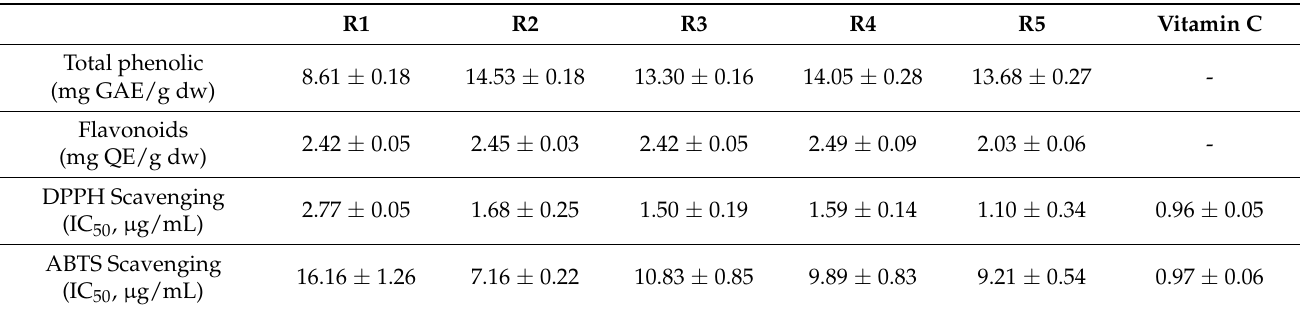
Table 1. Comparison of the total phenolics and flavonoids content and antiradical activity of R1–R5 extracts from various parts of R. platyacantha; each value represents mean ± SD ( n = 3). R1 R2 R3 R4 R5 Vitamin C Total phenolic 8.61 ± 0.18 14.53 ± 0.18 13.30 ± 0.16 14.05 ± 0.28 13.68 ± 0.27 - (mg GAE/g dw) Flavonoids (mg QE/g dw)